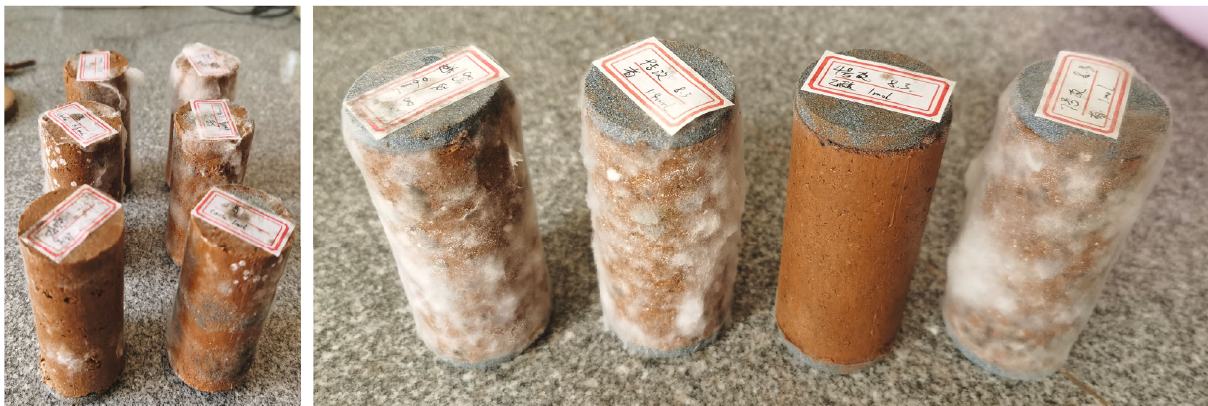
Figure 3: Sample of silty clay containing crushed stone after curing for 28d.